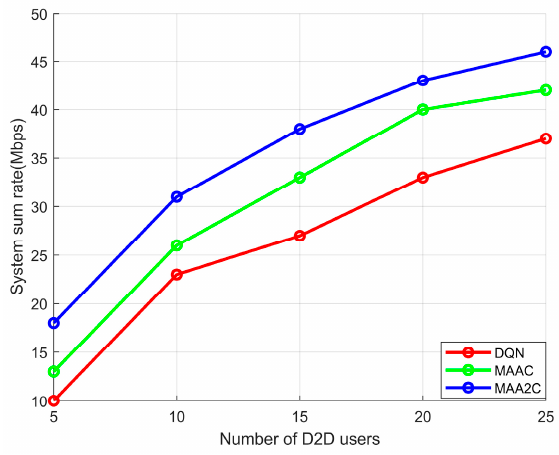
Figure 9. System sum rate (Mbps).